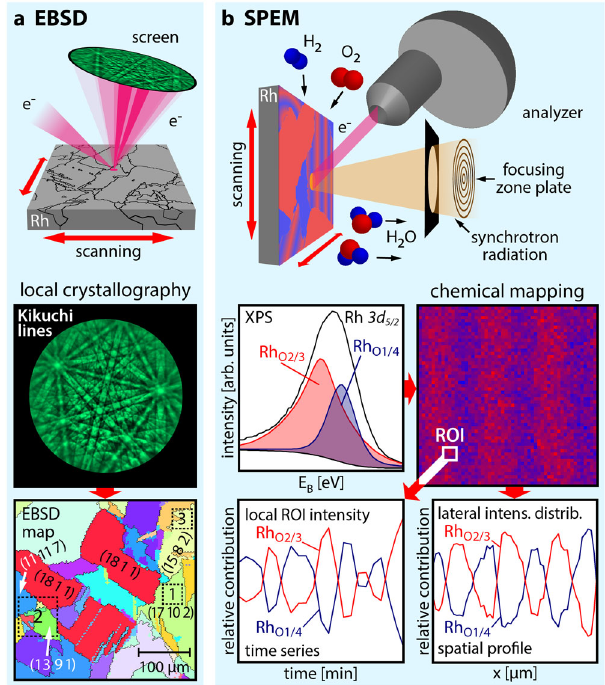
Fig. 1 Experimental approach. a EBSD: the backscattered electrons of a focused electron beam form Kikuchi lines on a phosphorous screen, enabling determination of the crystallographic orientation of each µ m-sized Rh domain; the square regions marked in the EBSD map correspond to those shown in Fig. 2a (region 1) and Fig. 3a (regions 2 and 3); b SPEM: the Rh surface is in situ raster-scanned by a sub- µ m-sized X-ray spot during H 2 oxidation, with the emitted photoelectrons providing local XPS spectra. The local adsorbate coverage obtained from the XPS data is displayed as a chemical map. Real-time monitoring reveals both temporal and spatial periodicity of individual spectral